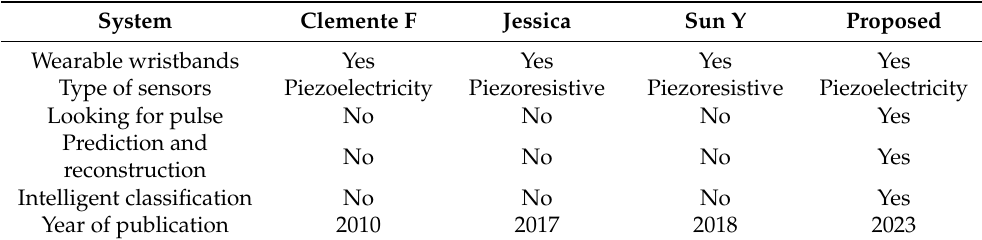
Table 4. Comparisons with other pulse measurement